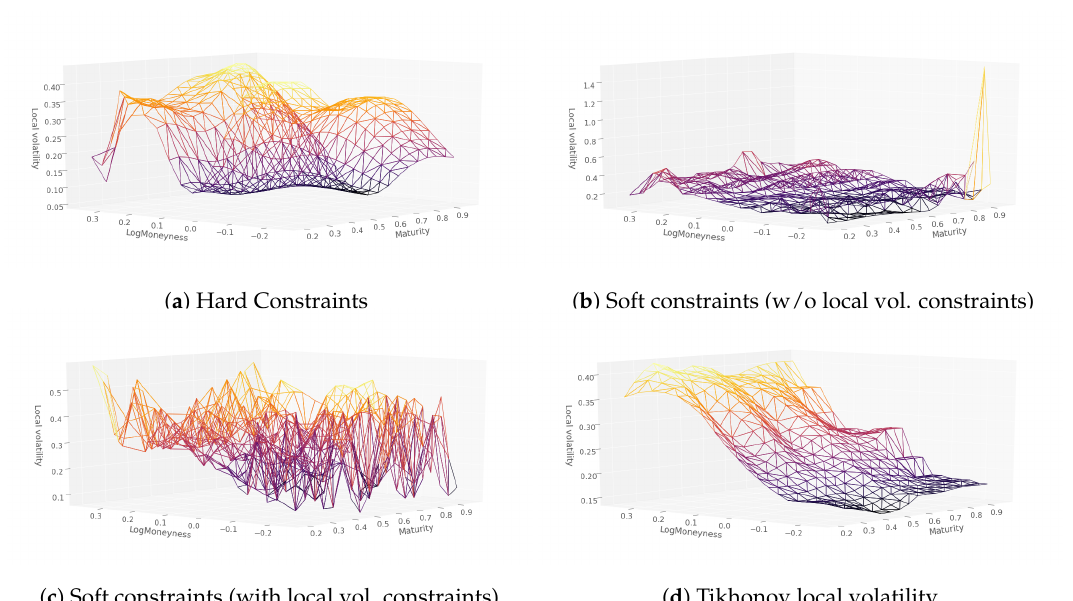
Figure 11. Local volatility for 8 August 2001.